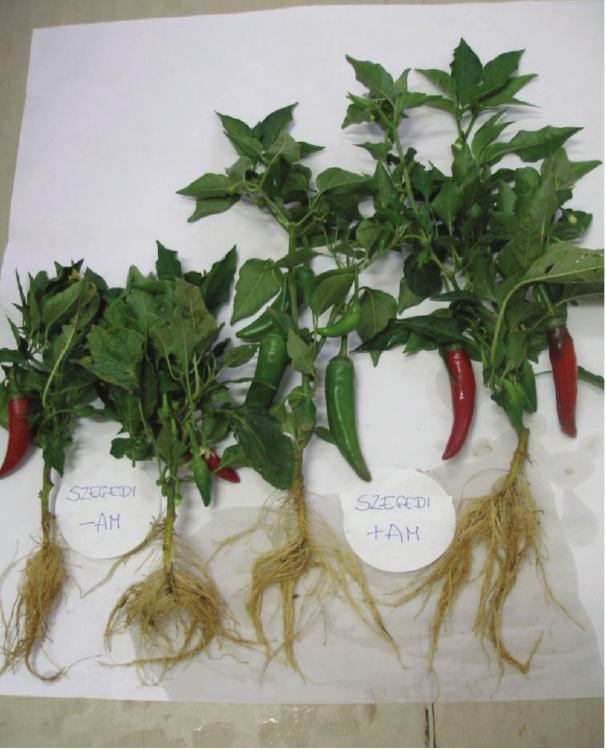
Figure 1. AM-treated and non-treated Capsicum annuum L. var. longum cv. Szegedi.